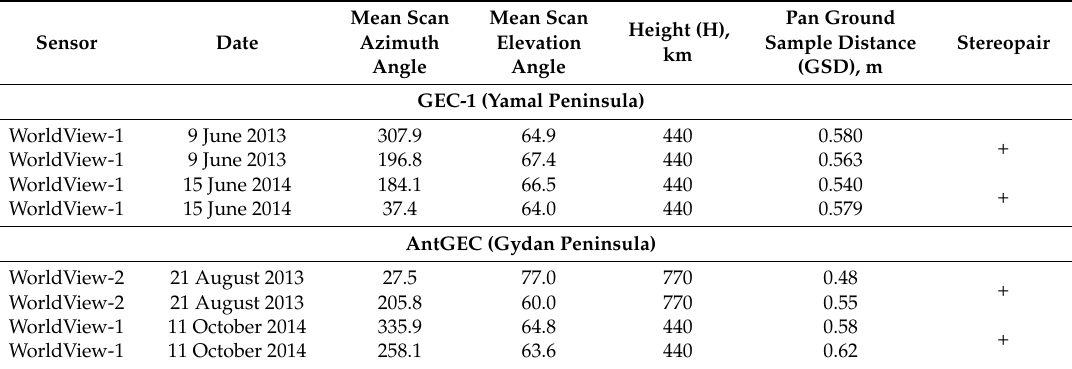
Table 1. Attributes of satellite data sets